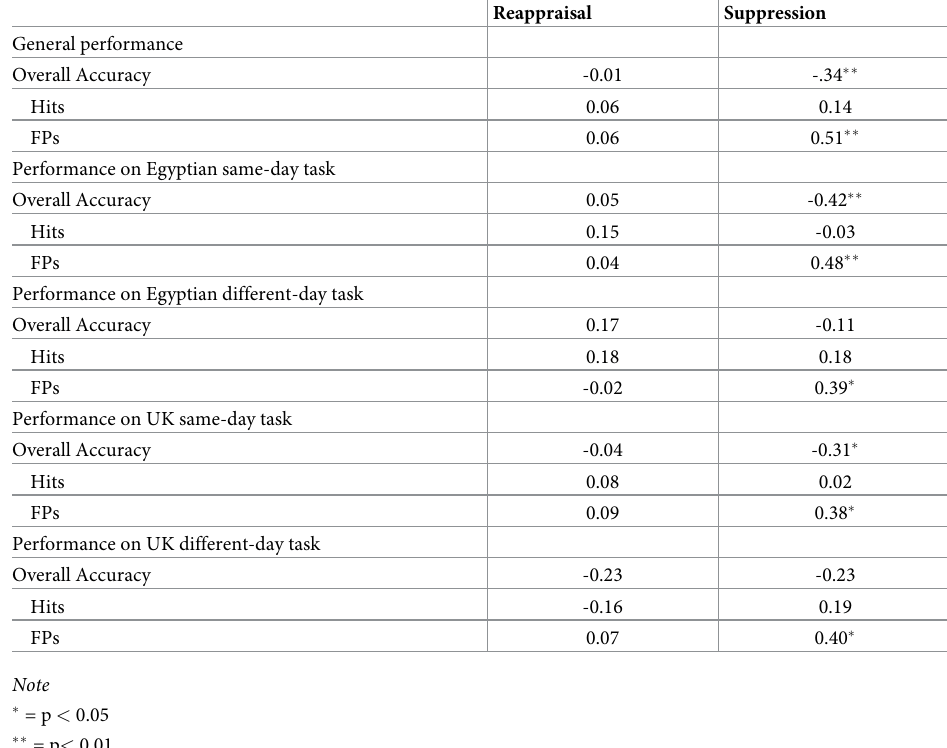
Table 4. Correlations between face matching and ERQ strategies in Experiment